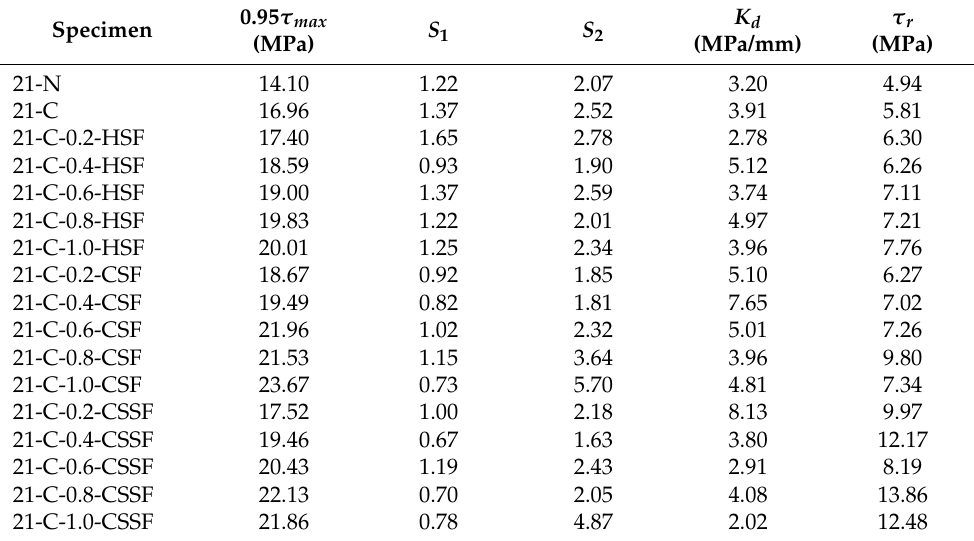
Table 7. Experimental results of the proposed